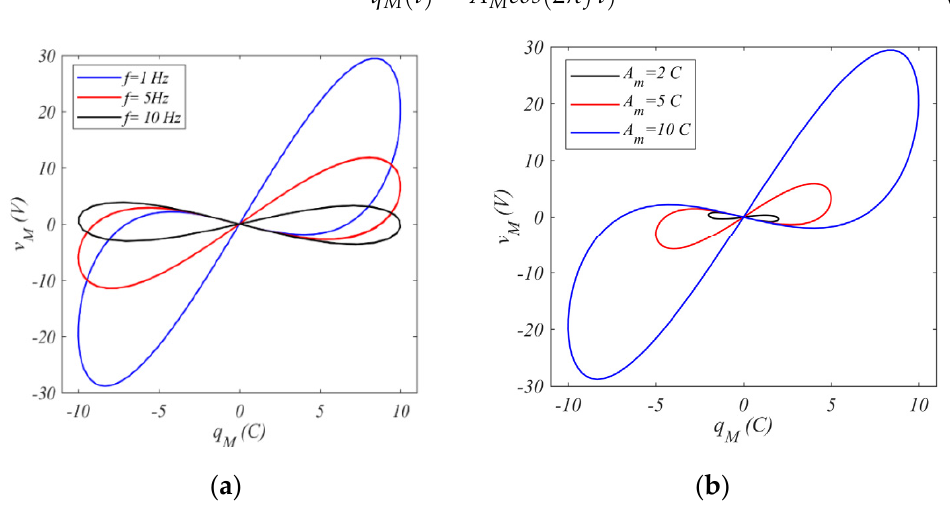
Figure 1. 𝑞 (cid:3014) − 𝑣 (cid:3014) characteristic curve of memcapacitor (9): ( a ) f = 1 Hz and various amplitude values; ( b ) A m = 10 C and various frequency values.